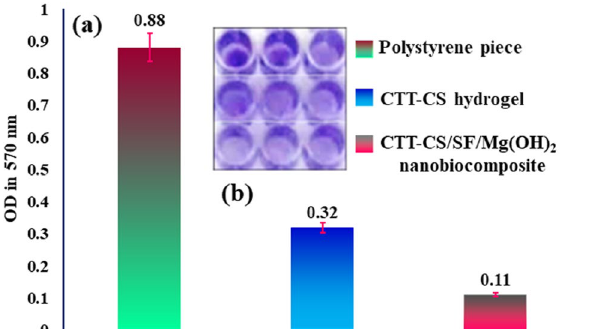
Figure 9. ( a , b ) Anti-biofilm histogram and 96-well plate image of polystyrene piece, CTT-CS hydrogel,